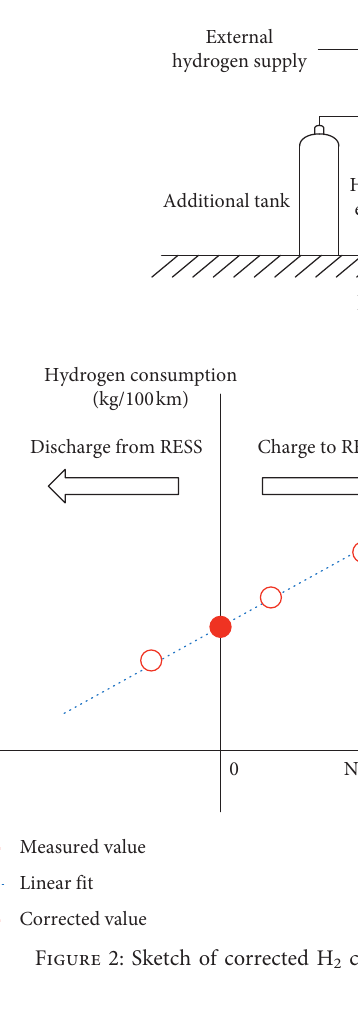
Figure 2: Sketch of corrected H